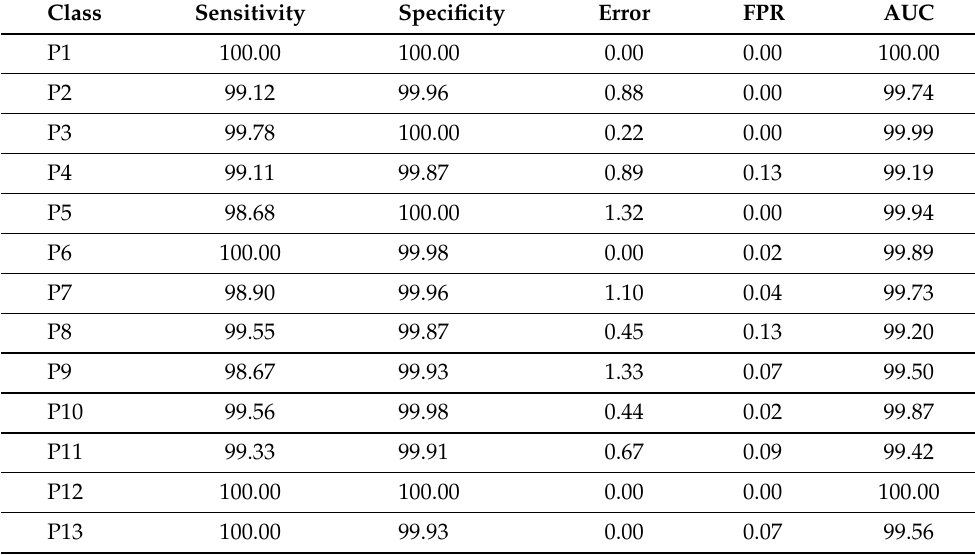
Figure 7. Comparison of accuracy for the machine learning models tested, considering several combinations of features from channel A2 acquired from the CP. Table 4. Performance metrics (in percent) obtained with the SVM model and the All Features set. The model was trained using vibration signals in channel A2 from the CP dataset. Class